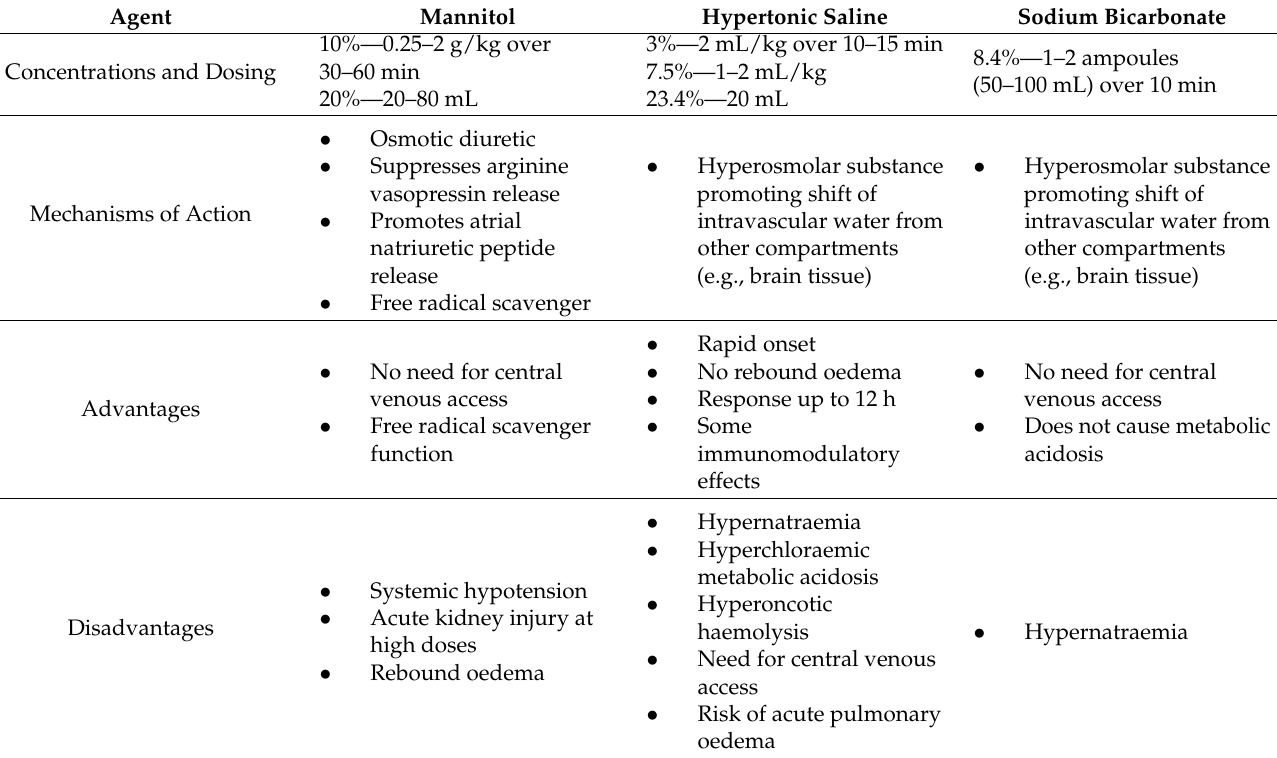
Table 1. Comparison of commonly used osmotherapy agents.